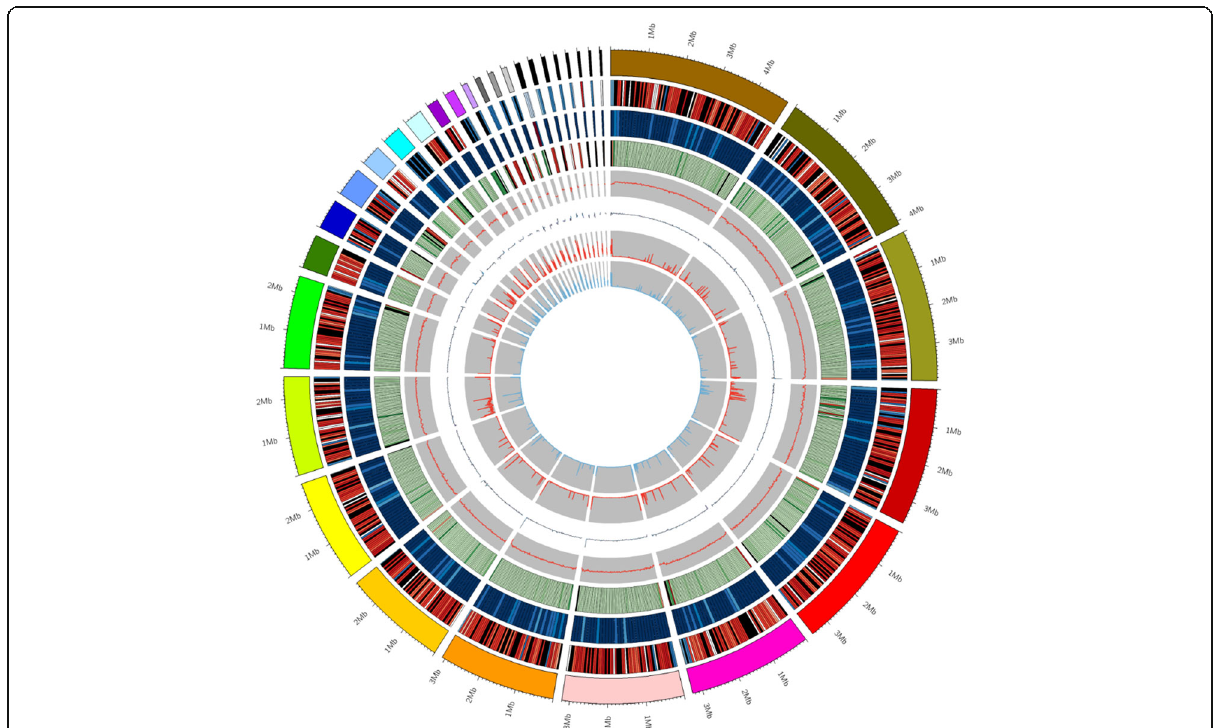
Fig. 4 CIRCOS plots of the Botryosphaeria dothidea LW-Hubei genome. CIRCOS plots of the 49 scaffolds of B. dothidea , including 12 scaffolds (length> 2Mb), are displayed in CIRCOS plots (Mb scale). The circus (from outside to inside) represent the following: 49 scaffolds (sorted by length), gene density (gene number in 50,000-bp non-overlapping windows), ncRNA density (ncRNA number in 100,000-bp non-overlapping windows), repeat coverage (repeat_coverage in 50,000-bp non-overlapping windows), GC (GC rate in 20,000-bp non-overlapping windows), GC_skew (GC skew in 20,000-bp non-overlapping windows), m4c and m6A methylations (100,000-bp non-overlapping